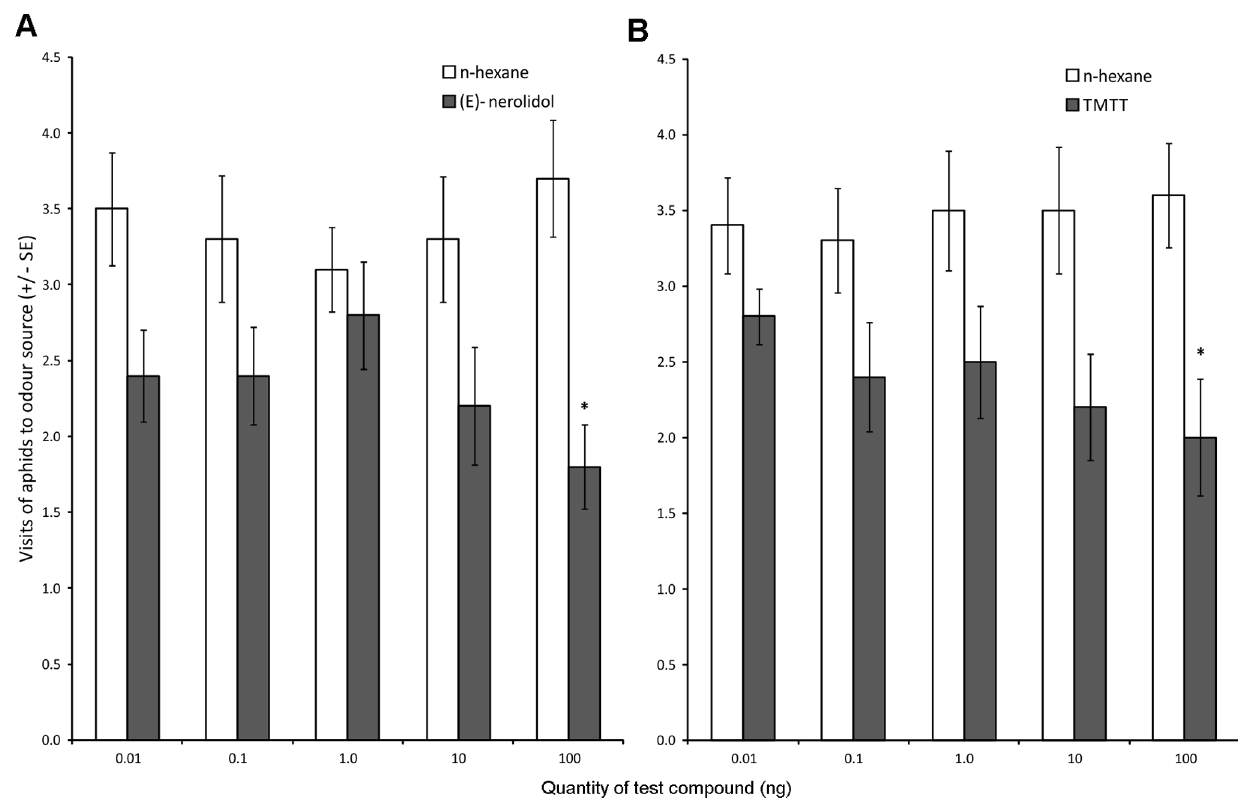
Figure 5. Aphid olfactory responses to two terpenoids realised in greater quantities from potato exposed to onion. Responses of winged Myzus persicae in olfactometer experiments when presented with test solutions containing different doses of (A) (E)-nerolidol, and (B) (3E, 7E) 4, 8, 12-trimethyl-1, 3, 7, 11-tridecatetraene (TMTT), alongside hexane control. Error bars indicate 6 SEM. *P # 0.05 Wilcoxon test.